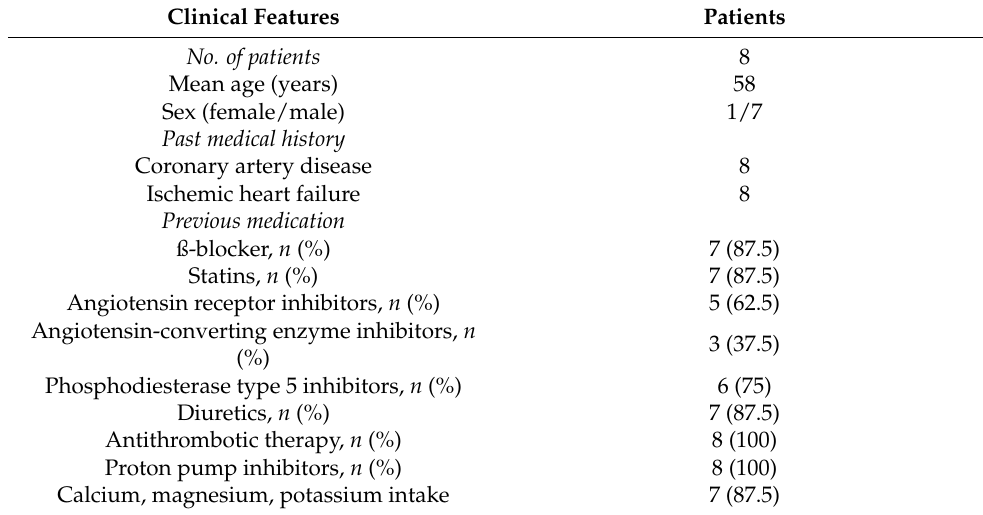
Table 1. Clinical features of ischemic heart failure